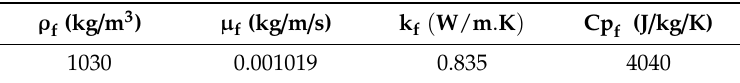
Table 3. 1% vol TiO 2 nanofluid physical properties.